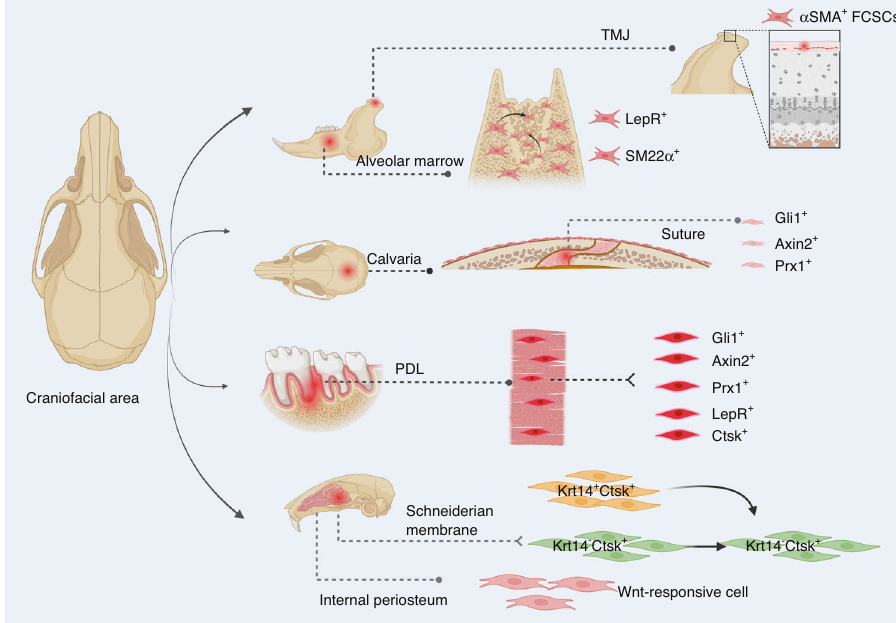
Fig. 2 Schematics of craniofacial progenitors for bone formation. Craniofacial region harbors various cell sources. From the latest literatures and our research, the indicated cell sources play crucial roles in craniofacial bone formation and